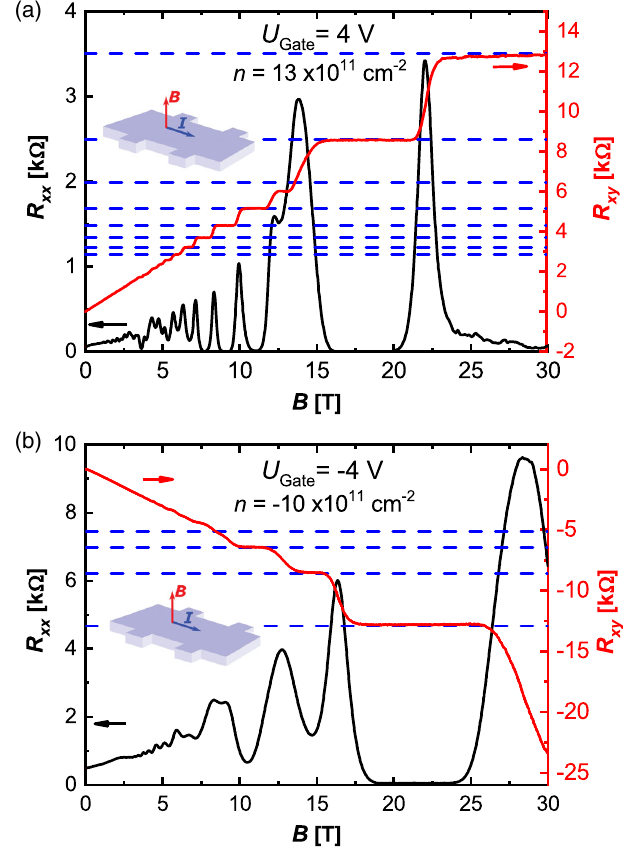
FIG. 6. Longitudinal resistance R xx and Hall resistance R xy as a function of the out of plane magnetic field B for high (a) electron and (b) hole densities at T ¼ 0 . 3